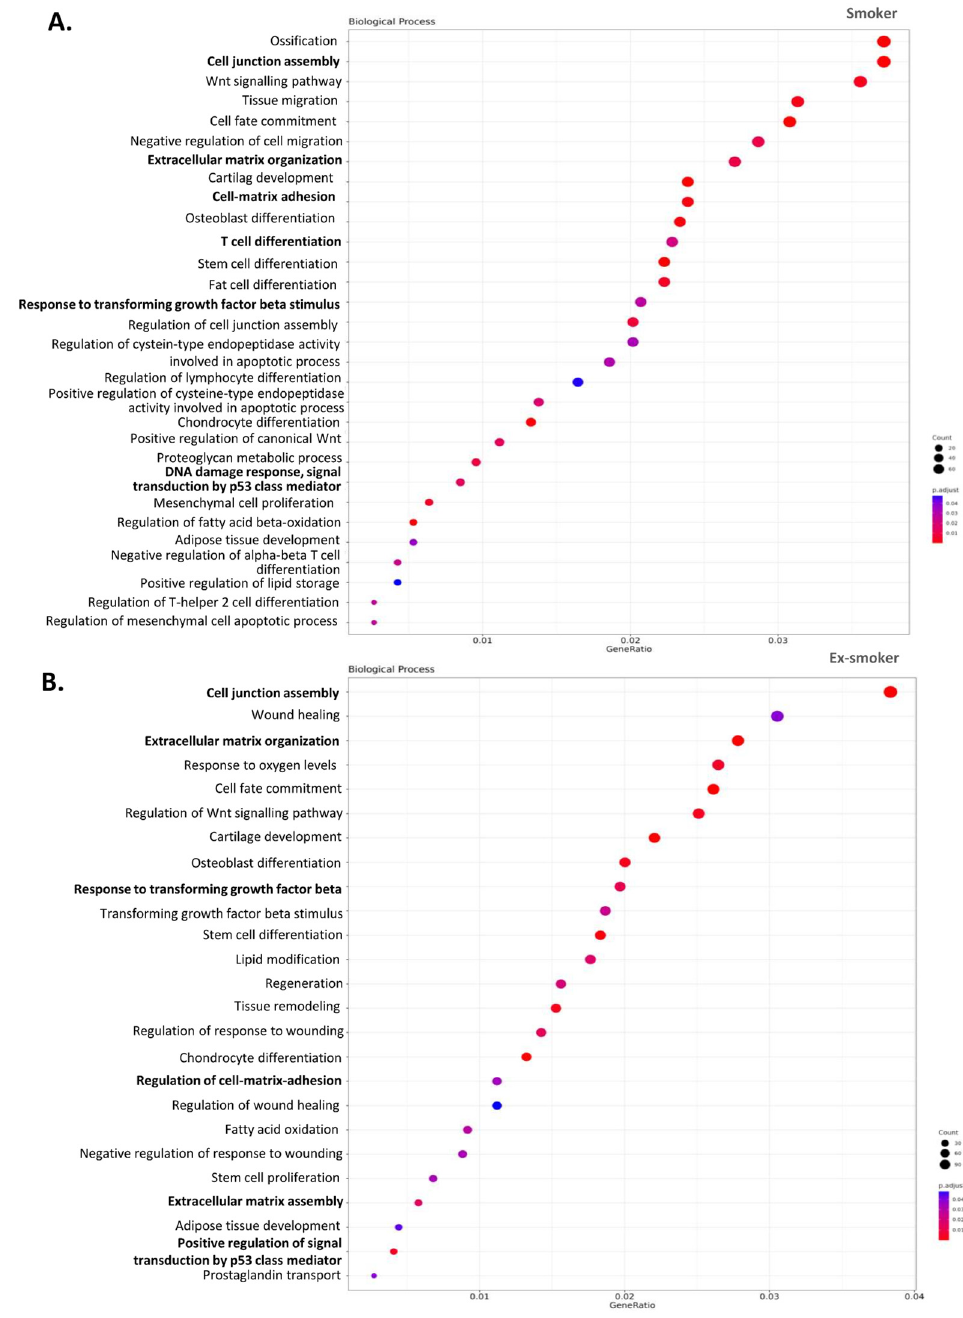
Figure 4. Cigarette smoking (current and past) disrupts the therapeutic properties in adipose stem cells from patients with Crohn’s disease. ( A ) Gene ontology (GO) enrichment analysis of the biological processes using the whole set of genes with significant DMRs obtained from the smoking group of patients and bubble plot for selected GOs. Different color scale represents the p -adjusted values and the size of the circles represents the number of genes implicated in each process. ( B ) GO enrichment analysis of the biological processes using the whole set of genes with significant DMRs obtained from the ex-smoking group of patients and bubble plot for selected GOs.